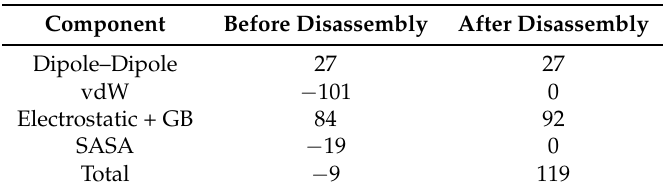
Table 1. Energy balance of different components of interaction energies between tubulin dimers at the tip of the seam of a microtubule (in kcal/mol) before and after disassembly. Component Before Disassembly After Disassembly Dipole–Dipole 27 27 vdW − 101 0 Electrostatic + GB 84 92 SASA − 19 0 Total − 9